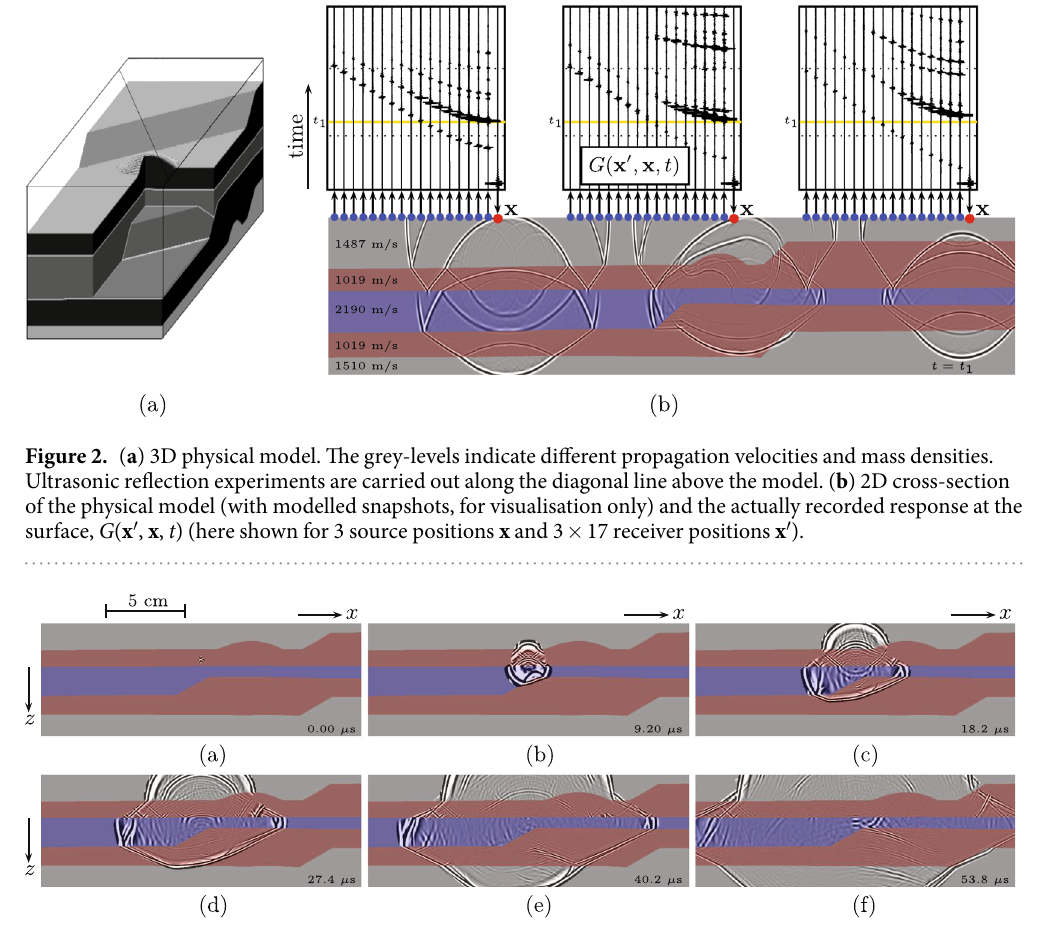
Figure 3. Virtual response G ( r , s , t ) + G ( r , s , − t ), retrieved from the single-sided ultrasonic reflection response G ( x ′ , x , t ) of the physical model in Fig. 2(a). ( a ) t = 0 μ s. ( b ) t = 9.2 μ s. ( c ) t = 18.2 μ s. ( d ) t = 27.4 μ s. ( e ) t = 40.2 μ s. ( f ) t = 53.8 μ